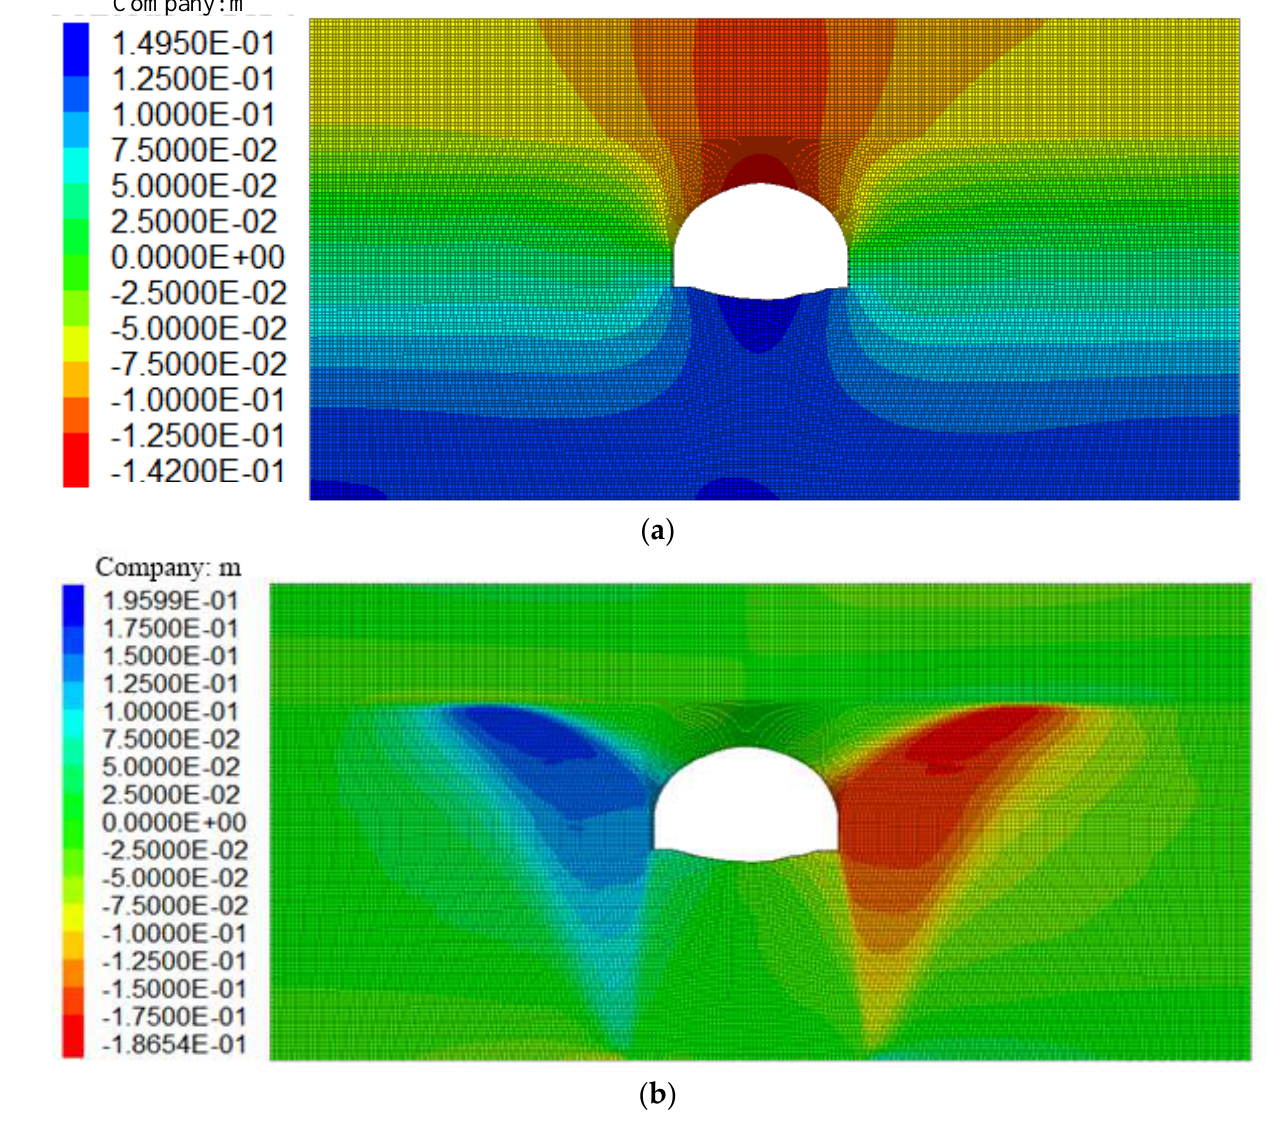
Figure 5. ( a ) Nephogram of vertical displacement and ( b ) nephogram of horizontal displacement. Nephograms of the displacement of the rock surrounding the